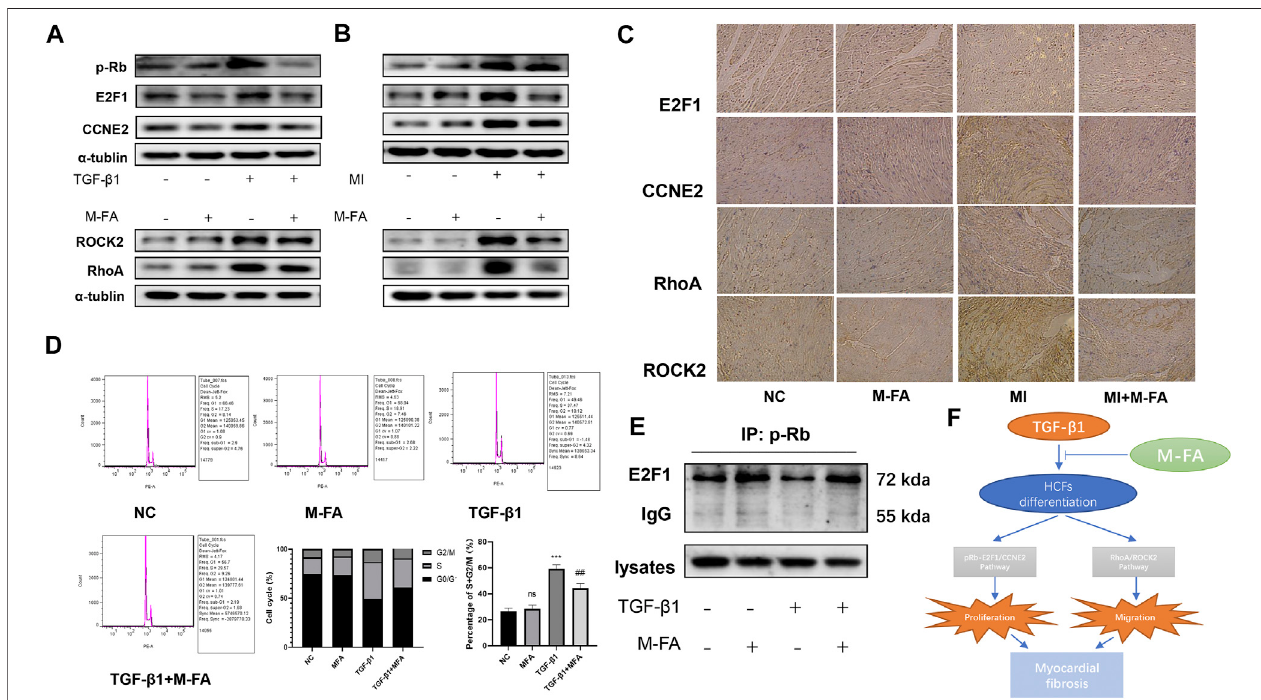
FIGURE 5 | MFA suppressed the expression of pRB, E2F1, CCNE2, RhoA, and ROCK2, regulated the cell cycle, and conjunction of RB and E2F1. (A – C) Protein expression levels of proliferation and migration-related genes in HCFs (A), mice LVs (B), and mice tissue (C) ( n (cid:2) 3). (D) Cell cycle analysis in HCFs ( n (cid:2) 6). (E) Immunoprecipitationofanti-pRBtoE2F1inHCFslysates. (F) Sketchmapofourassumptions.(*comparedwithnegativecontrol:*** p < 0.005. # ComparedwiththeTGF- β 1+MFA group: ## p < 0.01).